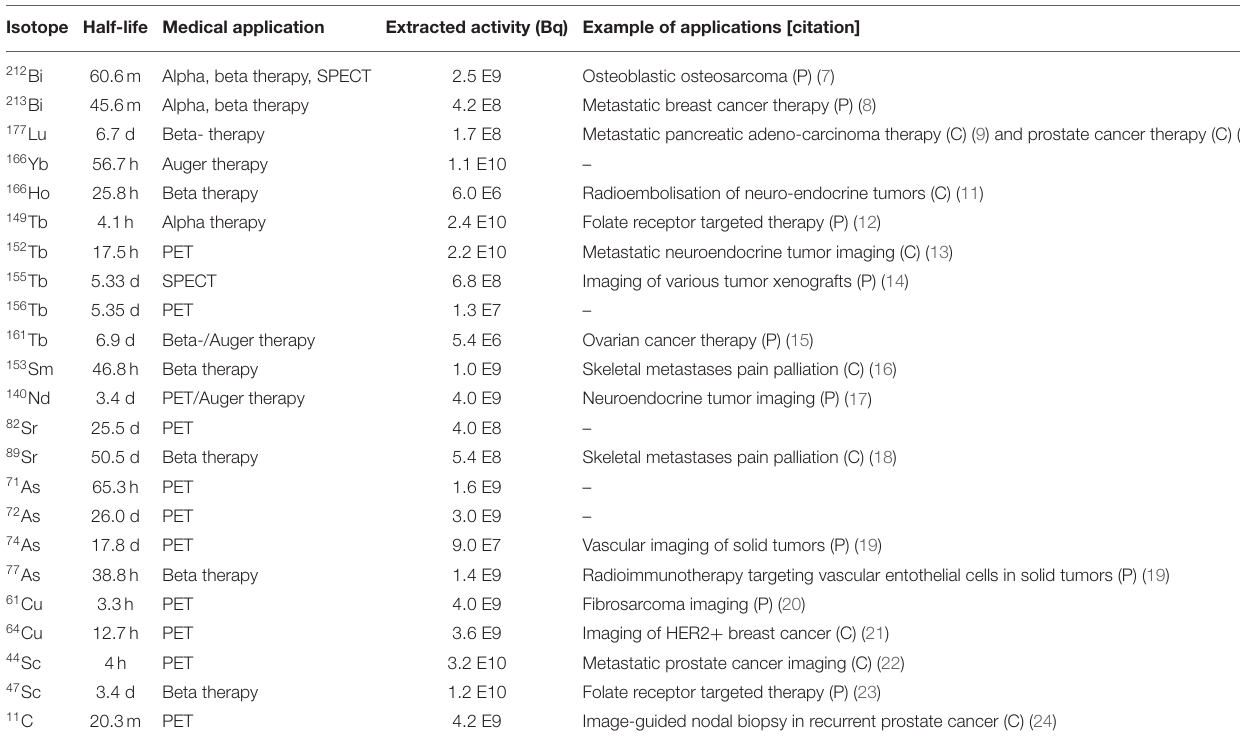
TABLE 1 | Isotope production at CERN-MEDICIS (non-exhaustive list) (7) and potential applications found in the literature (non-exhaustive list). Isotope Half-life Medical application Extracted activity (Bq) Example of applications